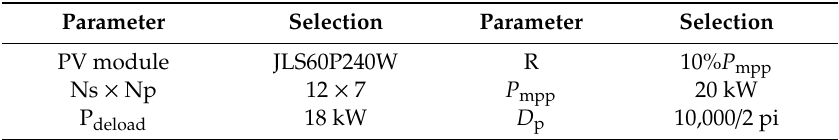
Table 3. Simulation parameters.